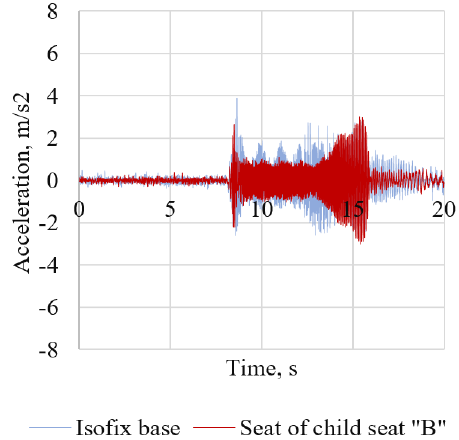
Figure 6: Vertical accelerations recorded on the seat B and ISOfix base (suspension in a dynamic position, the seat is loaded with a mass of 15